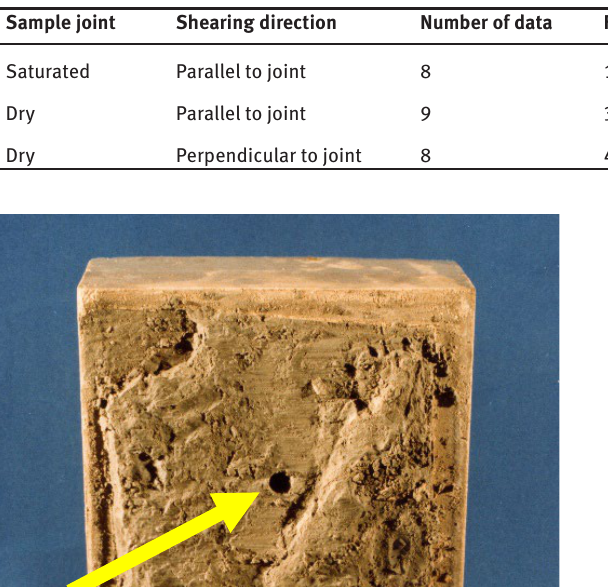
specimen subjected to direct shear test (the arrow indicates the hole Figure 7 : Campolattaro Marl in the middle for the rock joint saturation) (after ISMES 1982)